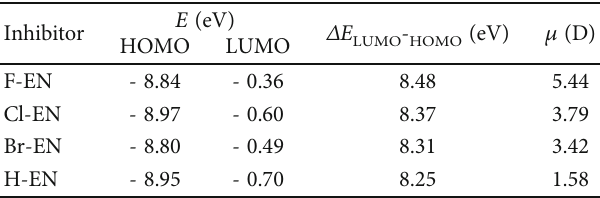
Table 9: Electronic properties of F-EN, Cl-EN, Br-EN, and H-EN obtained by semi-empirical PM6